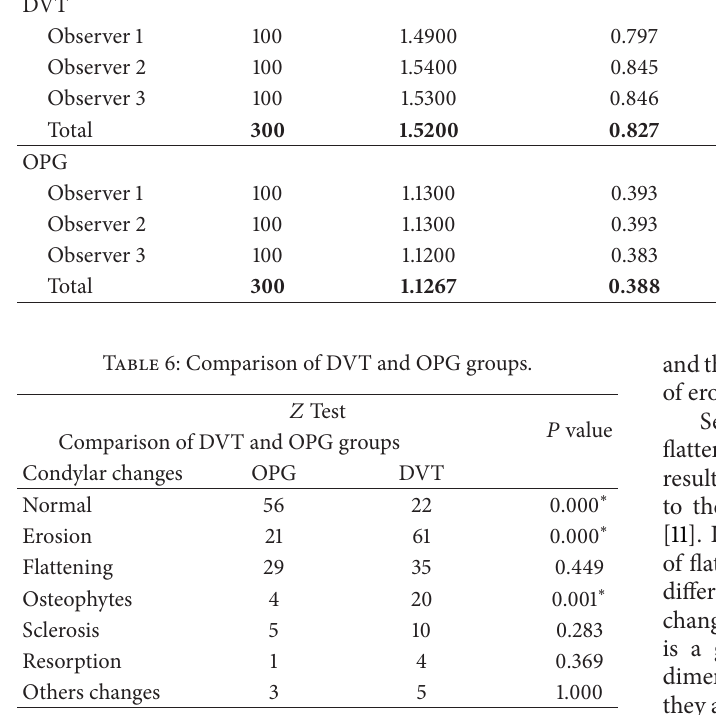
Table 5: One-way ANOVA test to see interobserver variation in DVT and OPG. 𝑁